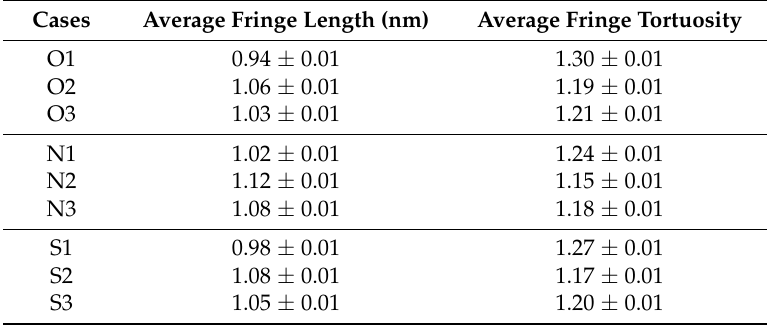
Figure 6. Skeletonized output images obtained by applying the fringe analysis algorithms to the HRTEM images in Figure 5. Table 2. Mean values of fringe length and tortuosity with standard deviations.